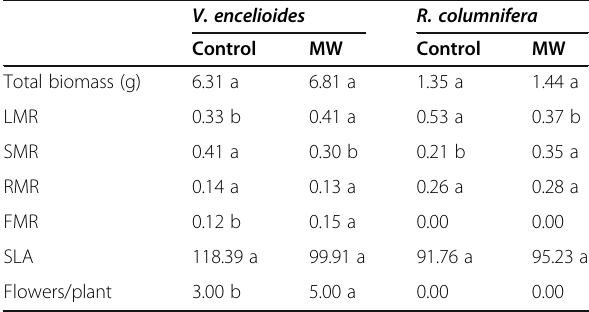
Table 1 Difference in plant growth and biomass allocation between the control and microbial wash (MW) treatments in V. encelioides and R.